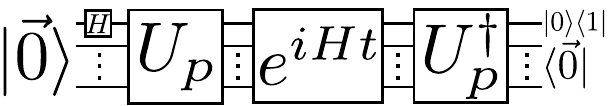
FIG. 2. Quantum circuit for control-free verified phase estima- tion. The preparation unitary U p is defined in Eq. (42). The first gate in the circuit is a Hadamard gate (roman H) on the top-most qubit (labeled the target qubit in the text), which should not be confused with the Hamiltonian H .